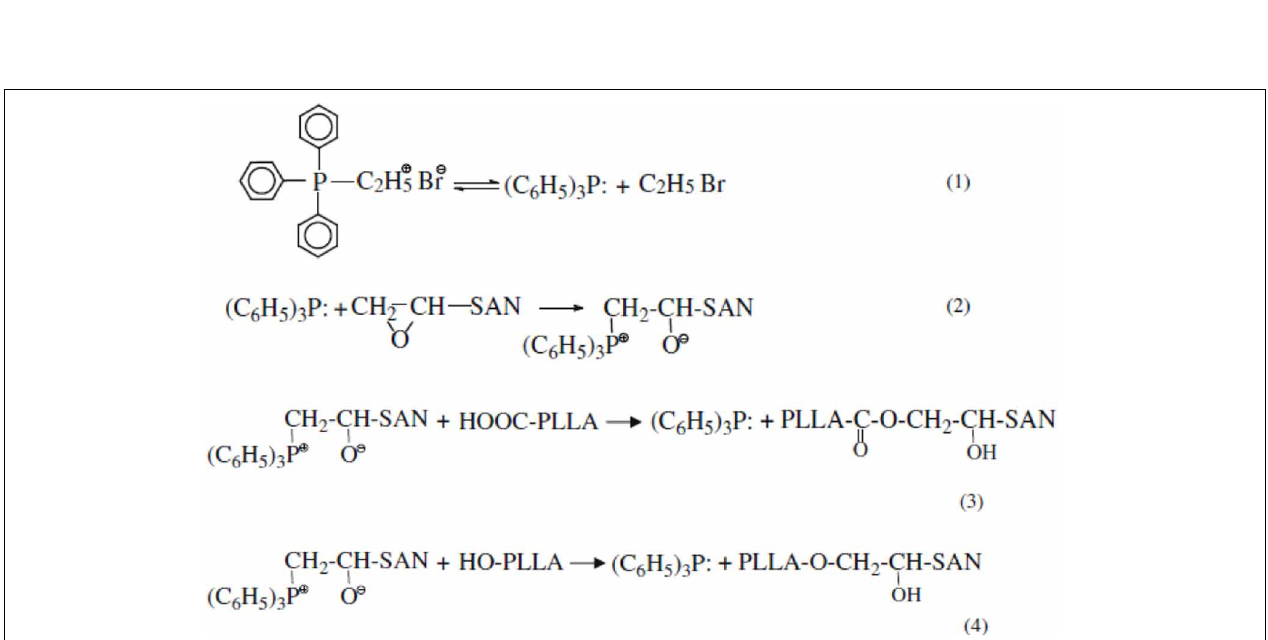
from Feng et al. (2013). (B) Strain–stress curve of PLA/POE and PLA/ POE-g-GMA blends [Reprinted from Su et al. (2009) with permission from